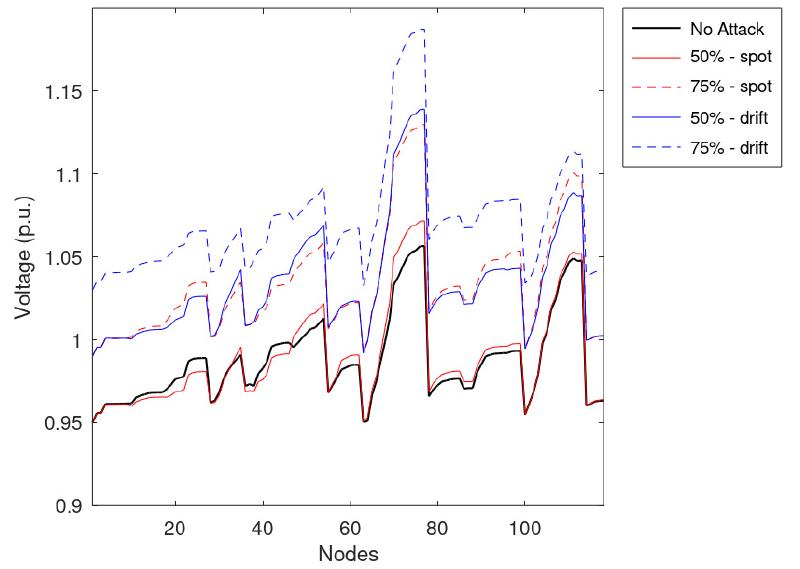
Figure 12. The voltage of the nodes during the maximum violation, assuming that 50 and 75% of measurements are manipulated.